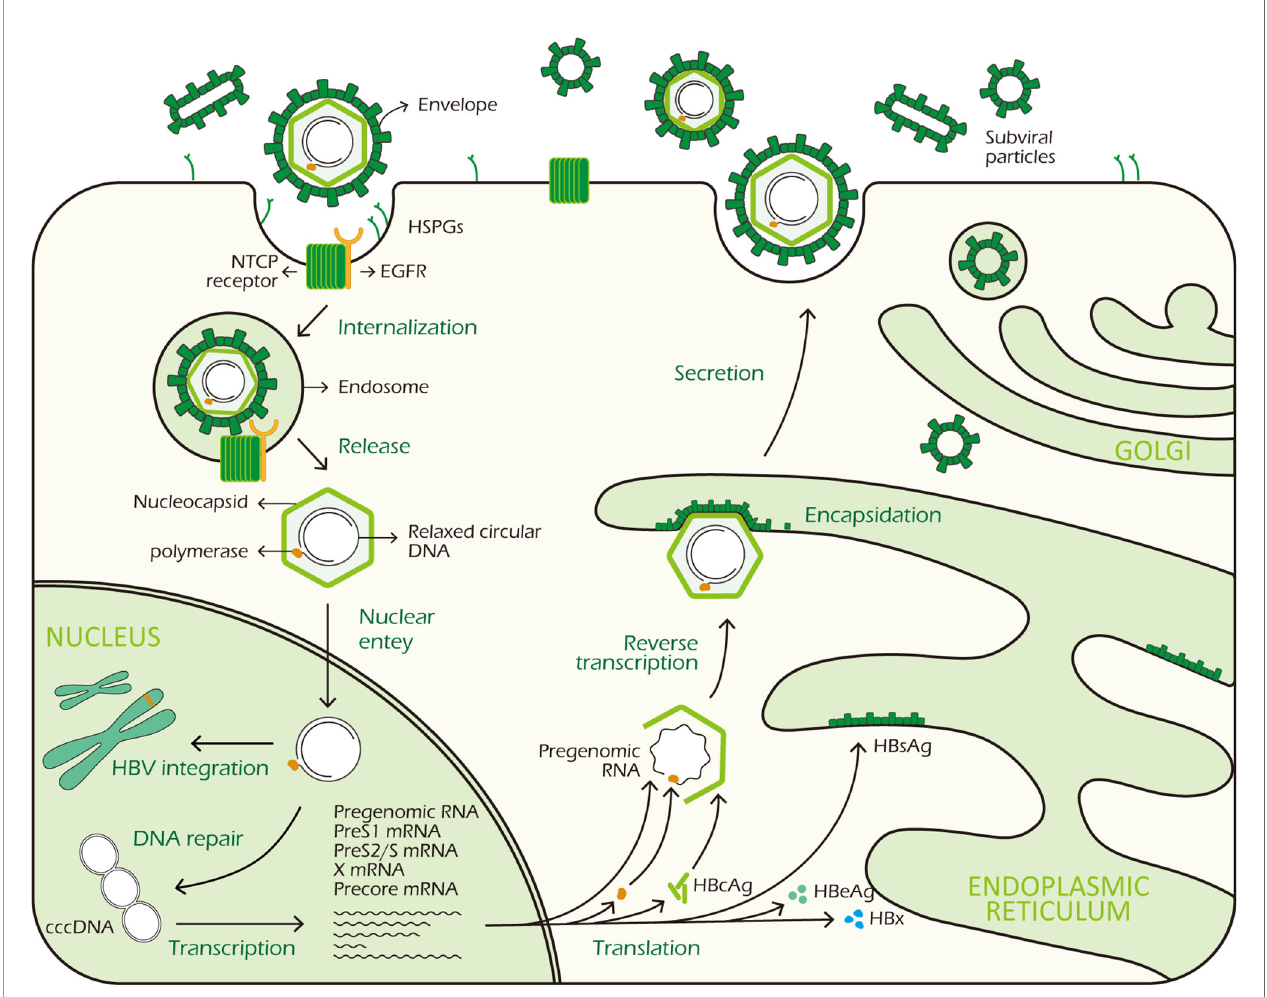
FIGURE 1 | HBV life cycle. HBV virus binds to HSPGs with low af fi nity to initiate infection, subsequently it interacts with NTCP receptor on the surface of hepatocyte to trigger viral internalization in a EGFR dependent manner. After being endocytosed, the virus releases its DNA-containing nucleocapsid into the hepatocyte cytoplasm which is subsequently transported to the nucleus. In the nucleus, the rcDNA is repaired and converted to cccDNA. At the same time, integration of viral DNA into host genome also takes place. The cccDNA minichromosome persists in the nucleus and functions as a transcription template for viral RNA transcription. It codes 7 viral proteins required for replication: 3 different sizes HBsAg, HBcAg, HBeAg, HBx and polymerase. In the cytoplasm, HBcAg proteins self-assemble into icosahedral nucleocapsid to package viral polymerase and pgRNA. After reverse transcription in nucleocapsid, HBV genome-containing capsid binds to HBsAg proteins in the ER for encapsidation. Finally, mature HBV viruses exit the hepatocytes via